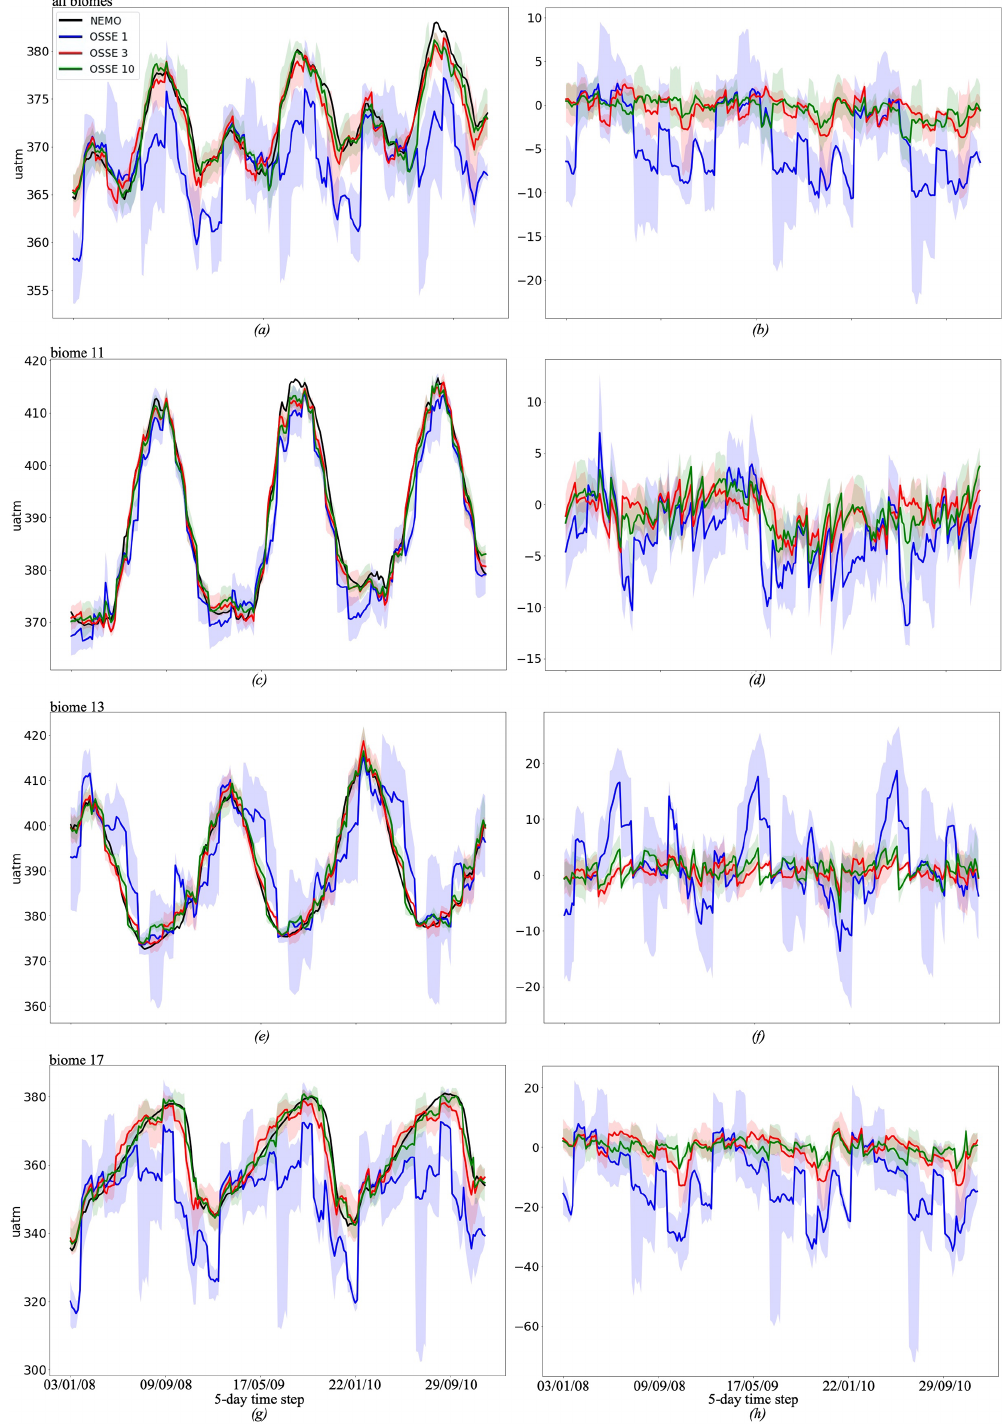
Figure 7. (a, c, e) Mean of four FFNN outputs for OSSE 1 (blue) (SOCAT data only), 3 (red) (SOCAT and synthetic Argo data), and 10 (green) (SOCAT data, 25% of the original synthetic Argo data in the Southern Hemisphere, and data from mooring stations); shading corresponds to the maximum and minimum values from four FFNN outputs for each OSSE. The black curve shows NEMO/PISCES p CO 2 . (b, d, f) Mean of differences of four FFNN outputs between OSSE 1 (blue), 3 (red), and 10 (green) and NEMO/PISCES p CO 2 ; shading corresponds to the maximum and minimum values of differences from four FFNN outputs for each OSSE. (a, b) Estimates are available over all biomes presented in Fig. 2, except biome 8: (c, d) biome 11 (subtropical permanently stratified North Atlantic), (e, f) biome 13 (subtropical permanently stratified South Atlantic), and (g, h) biome 17 (Southern Ocean ice). https://doi.org/10.5194/os-17-1011-2021 Ocean Sci., 17, 1011–1030,